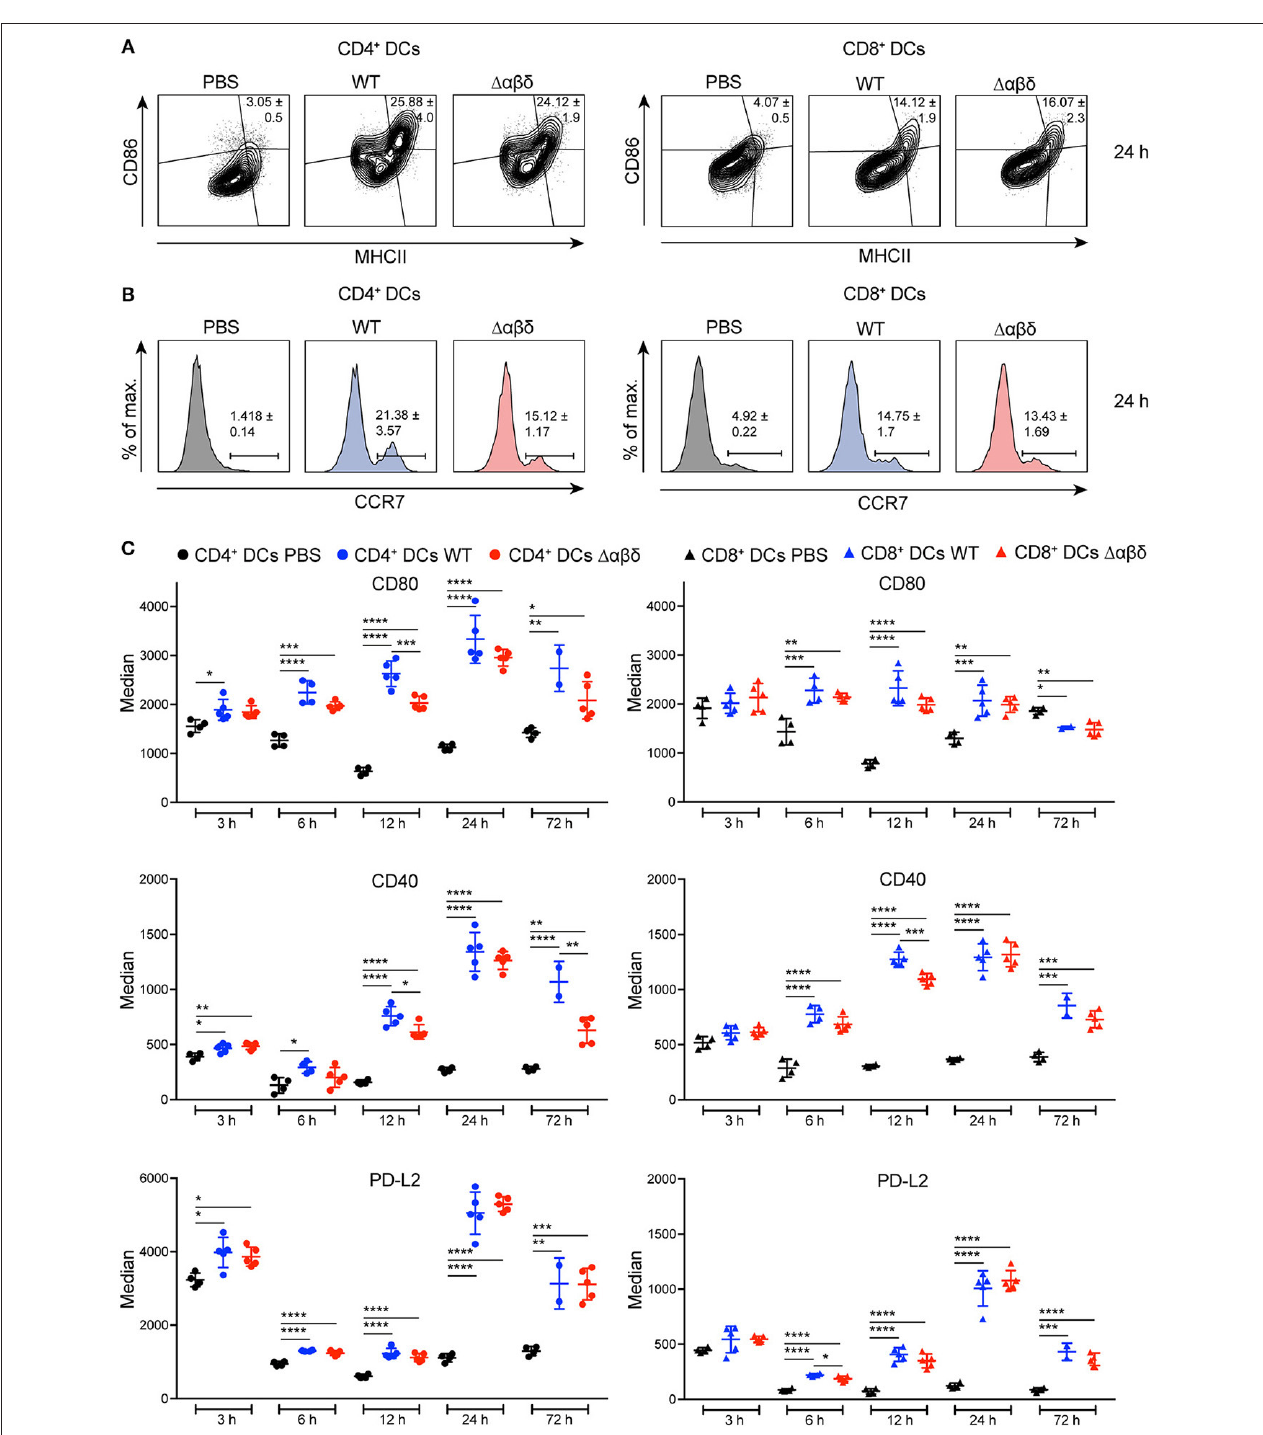
FIGURE 2 | DC maturation upon S. aureus infection. C57BL/6J WT mice were either treated with PBS or infected with S. aureus USA300 WT or the PSM-deficient S. aureus USA300 1 αβδ mutant strain for up to 3 days and splenocytes were stained with CD11c, MHC class II, CCR7, CD80, CD86, CD40, and PD-L2 antibodies and analyzed by flow cytometry. Representative contour plots and histograms show the frequency of (A) MHC II + CD86 + cells and (B) CCR7 + cells, respectively, among CD4 + (left) and CD8 + (right) DCs in the spleen of PBS-treated or infected mice after 24h. (C) Graphical summary of the median expression of CD80, CD40, and PD-L2 by CD4 + (left) and CD8 + (right) DCs in the spleen of PBS-treated or infected mice over time. Every symbol represents one mouse; quantity of mice and experiments per condition and time is depicted in Table S2 . The graphs represent the mean ± SEM with data from one or pooled from 2 experiments (one-way ANOVA followed by Tukey’s post-hoc test; * p < 0.05, ** p < 0.01, *** p < 0.001, **** p < 0.0001).